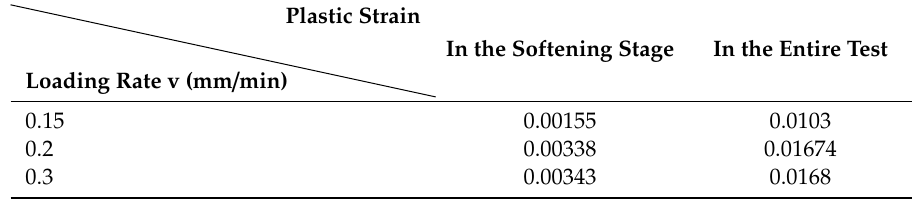
Table 3. Plastic strain produced in the softening stage and in the entire test under different loading rates.